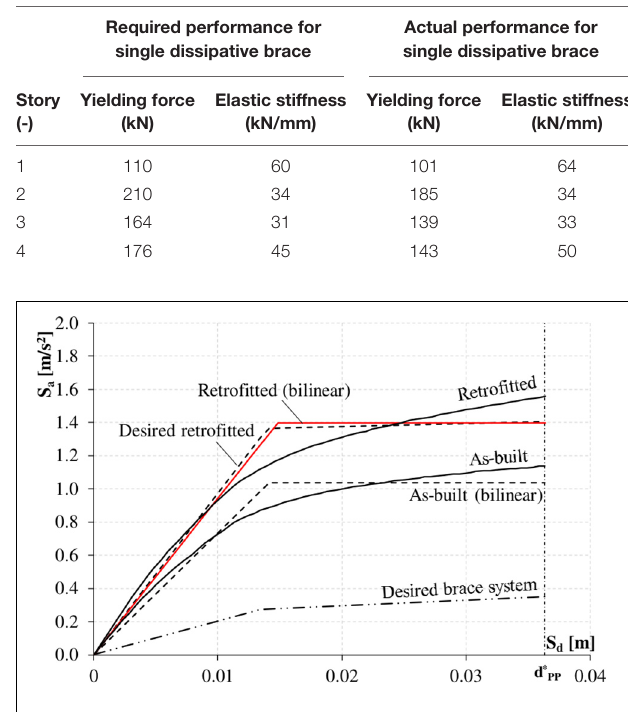
FIGURE 14 | As-built and retrofitted capacity